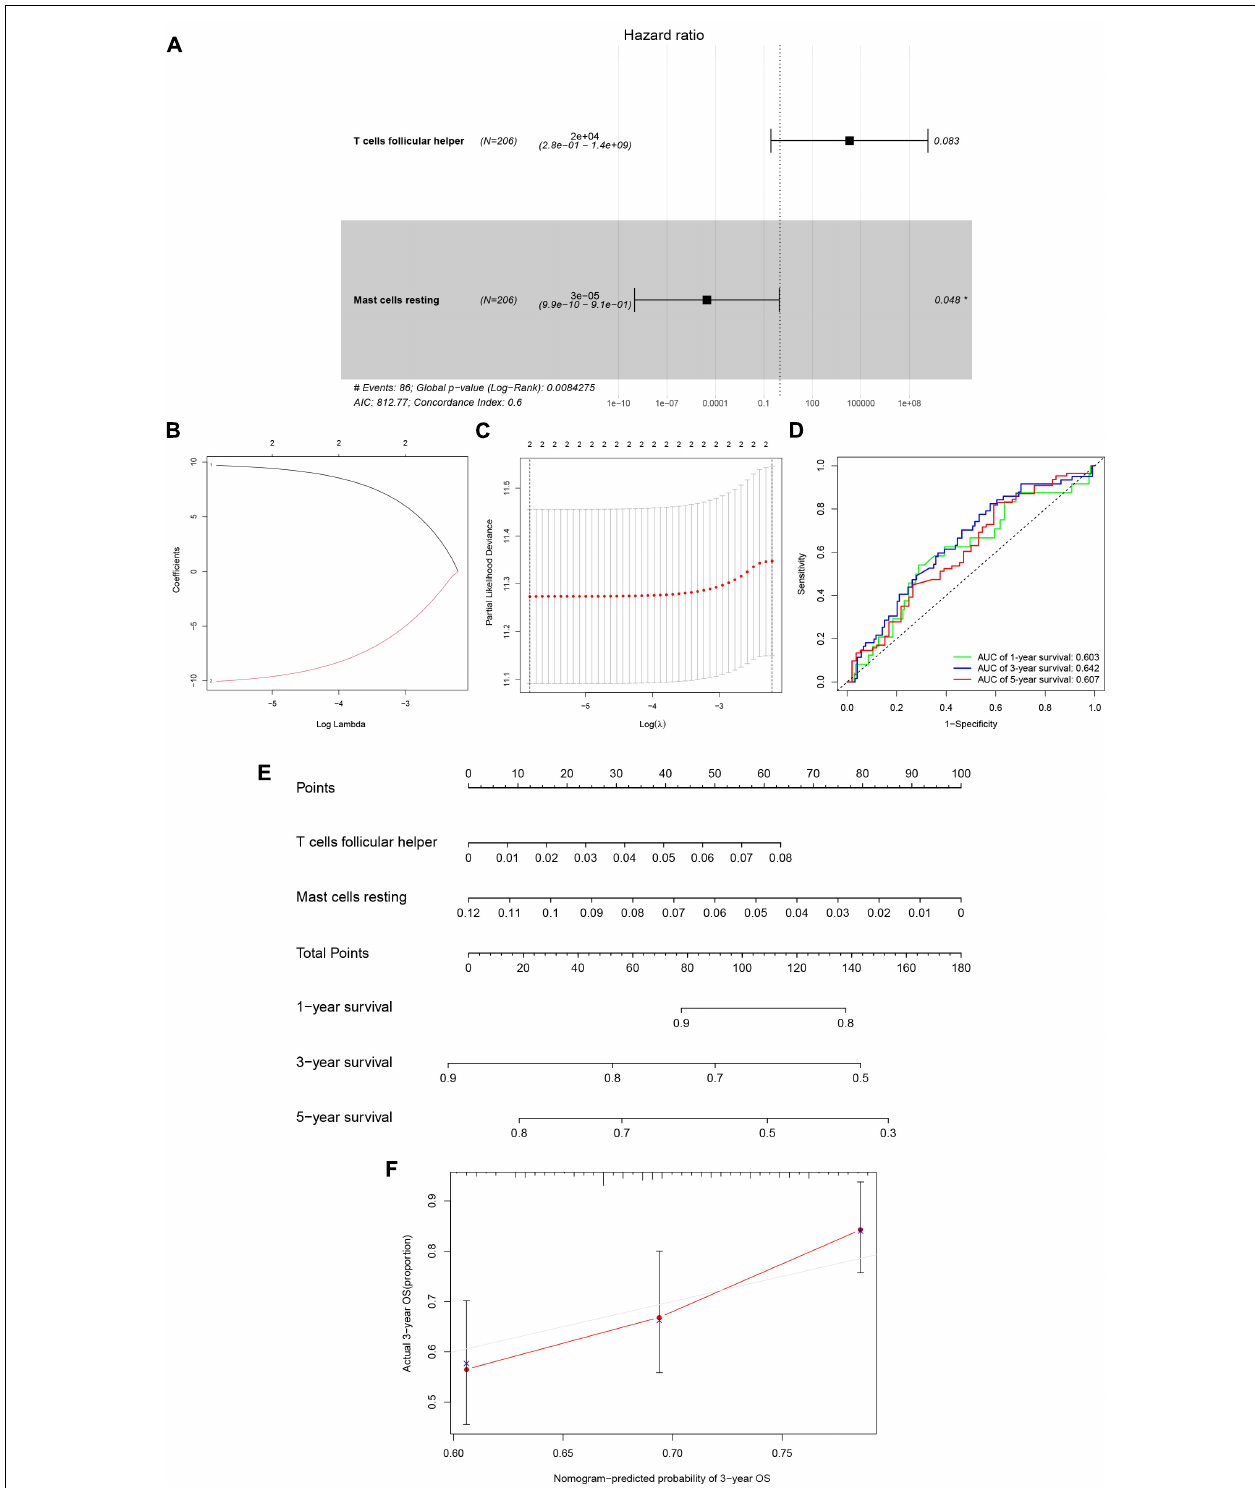
FIGURE 6 | The Cox proportional hazards regression model (A) based on immune cells screened by Lasso regression analysis (B,C) . Tfh cells and resting mast cells were integrated into the Cox proportional hazards regression model. The nomogram (E) was constructed based on the model. The ROC (D) and the calibration curves (F) indicate the acceptable accuracy (AUCs of 1, 3, and 5-year survivals: 0.603, 0.642, and 0.607) and discrimination of the nomogram. * P < 0.05.